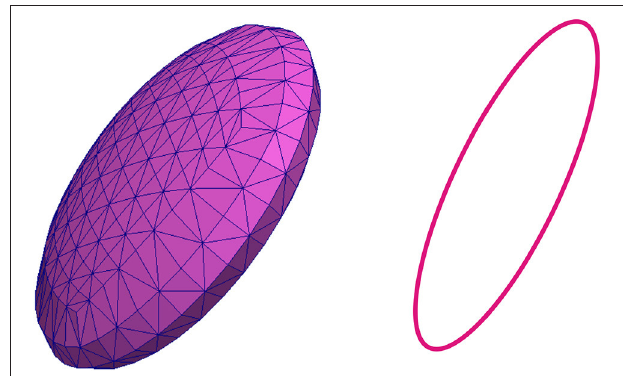
FIGURE 2 | Discretized model of the membrane representing the red blood cell that is used in numerical simulations (left) and the cross-section of the discretized model of the RBC along the plane that contains the center of gravity of the RBC